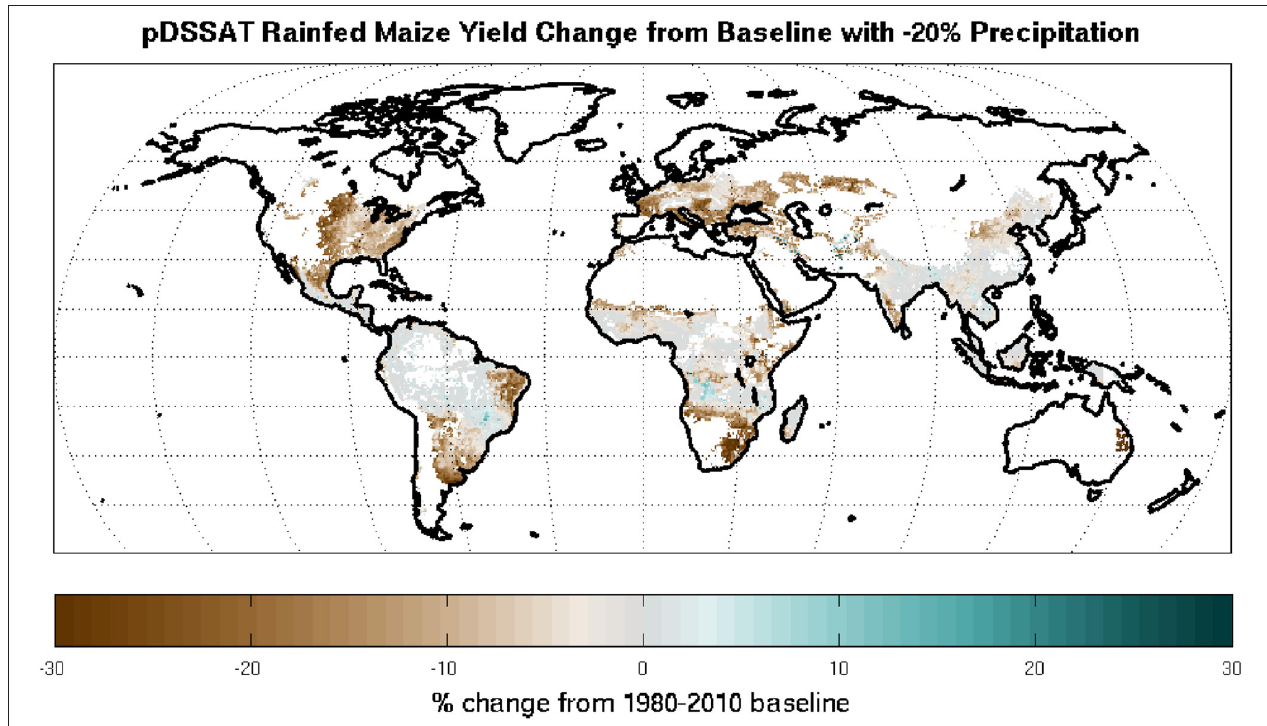
FIGURE 7 | Example of process-based crop model response map that motivates global and regional interventions. Rainfed maize yield response to a 20% reduction in precipitation, as simulated by the pDSSAT crop model as part of AgMIP’s Global Gridded Crop Model Intercomparison. Note that only grid cells are shown where